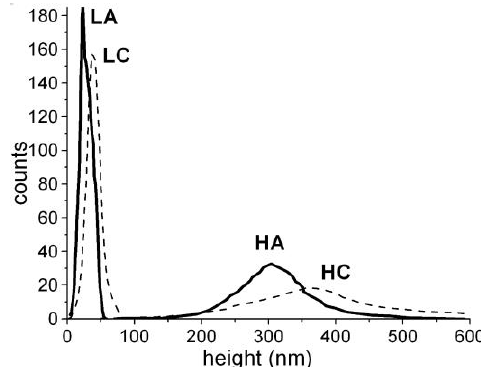
Figure 4. AFM height distributions for the studied samples: ( a ) HA; ( b ) HC; ( c ) LA; and ( d ) LC samples.